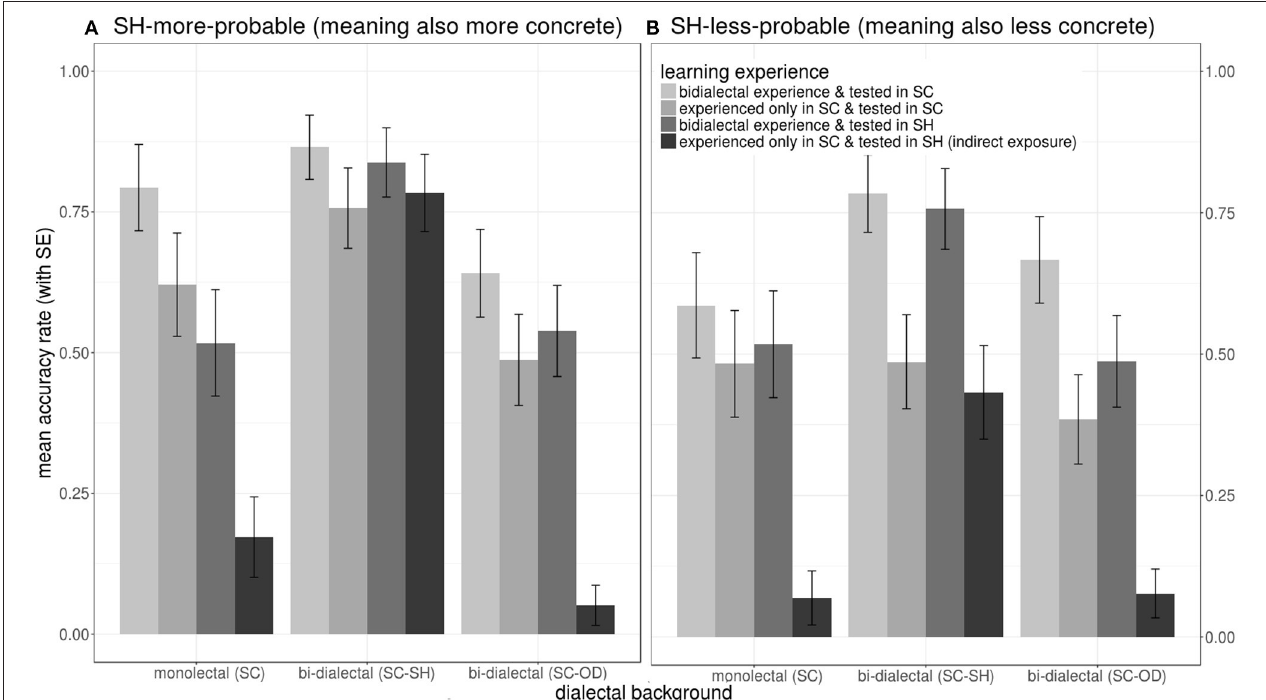
FIGURE 11 | Effects on mean accuracies during the lexical naming test, showing interactions of the learning experience (a combination of the participants’ exposure to target words prior to the naming task and language of operation in the naming task , color) and dialectal background (cluster), in response to SH-more-probable (A) (left panel) and SH-less-probable (B) (right panel)